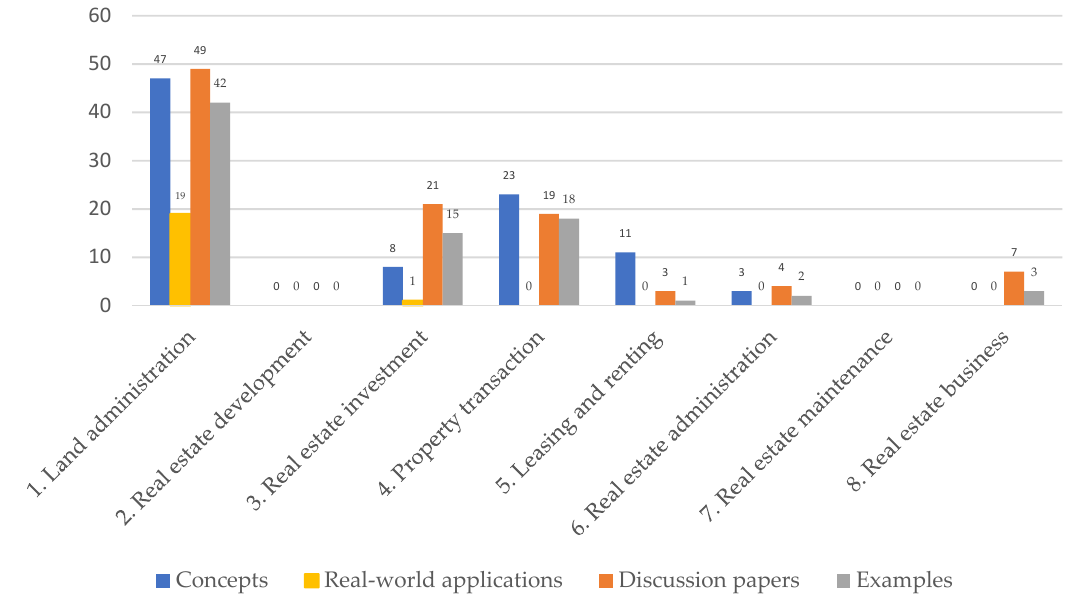
Figure 4. Document classification by real estate subsectors and paper types. The papers heavily focused on land administration, representing 58% of the